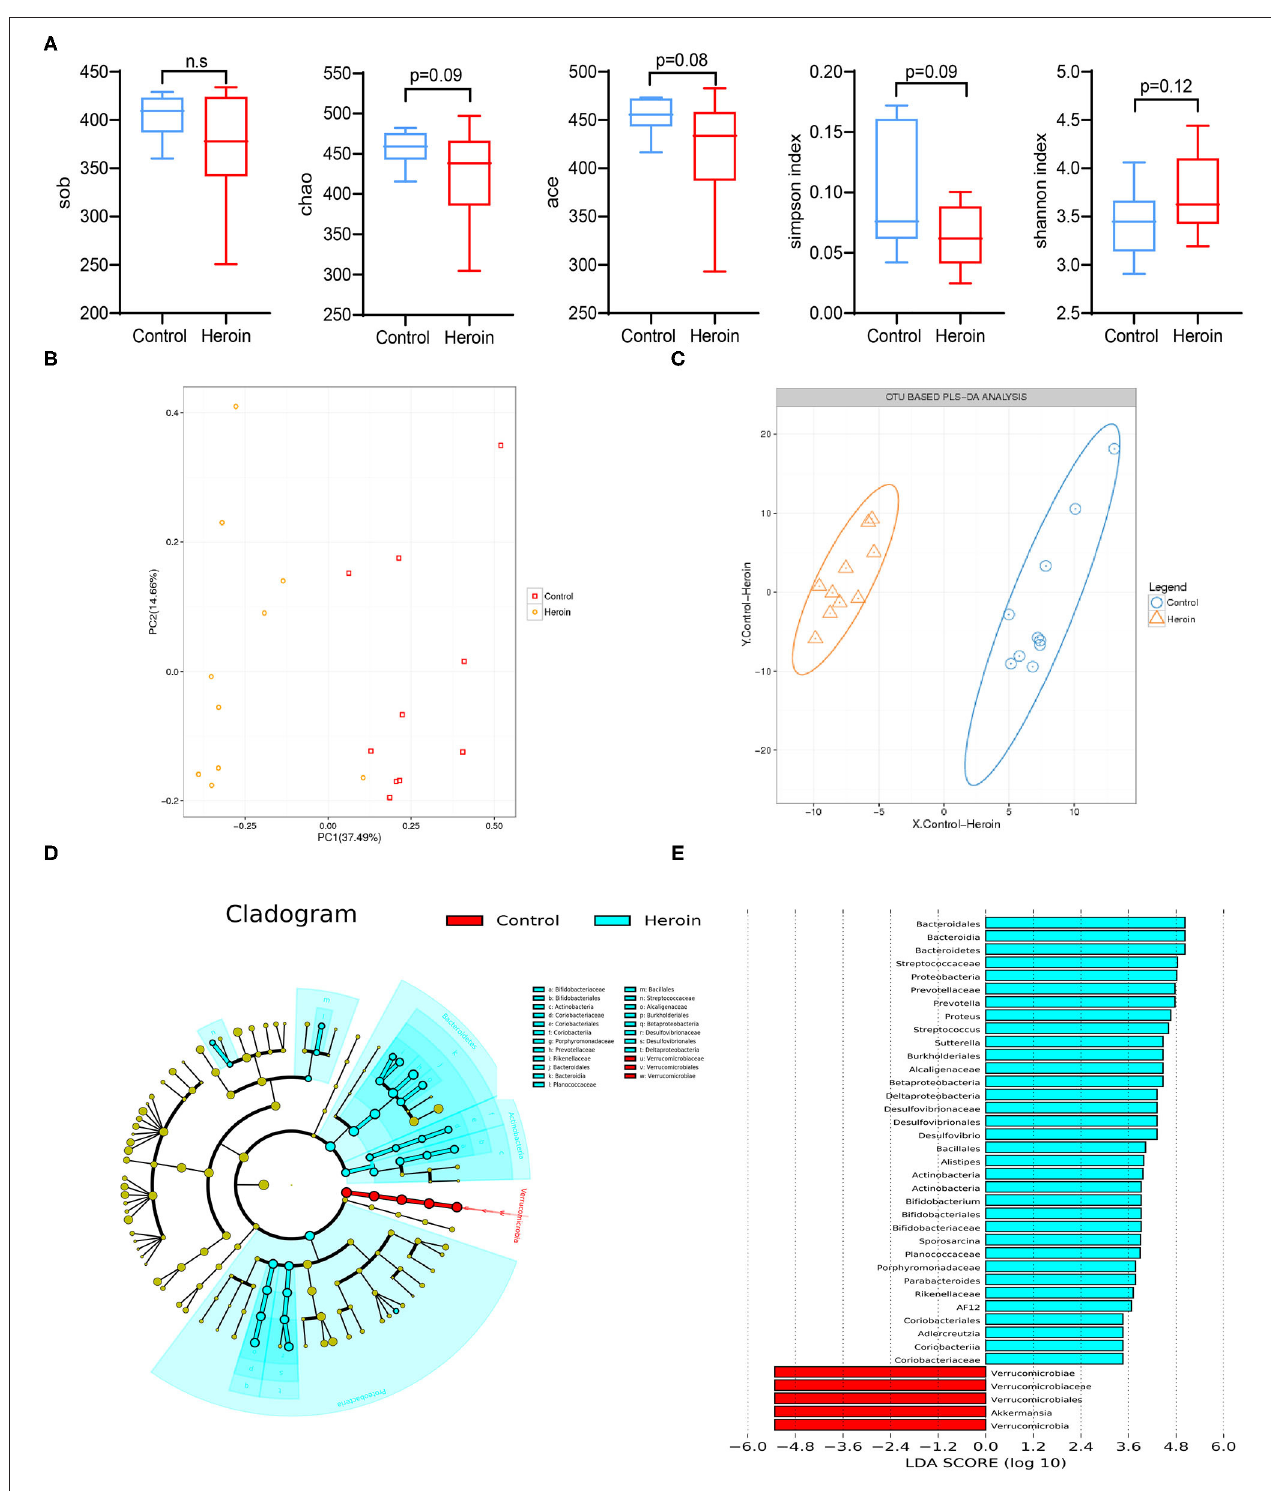
FIGURE 3 | Heroin administrated altered the gut microbiota structure and diversity. (A) Comparison of the alpha-diversity indices between the control and heroin groups based on the observed species, chao, ace, shannon, and simpson index. (B) Principal coordinate analysis (PCoA) of the samples using Unweighted-UniFrac from pyrosequencing. The red squares represent the control group, and the yellow dots represent the heroin administrated group. The fecal microbiotas of the two groups could be divided into clusters according to community composition using Unweighted UniFrac metrics and separated clearly using PCoA analysis. (C) Operational taxonomic unit (OUT)-based partial least-squares discrimination analysis (PLS-DA). (D) Linear discriminant analysis effect size (LEfSe) cladogram representing differentially abundant taxa. (E) Linear discriminant analysis (LDA) scores, as calculated by the LEfSe of differentially abundant taxa in the two groups. Cladogram showing differentially abundant taxonomic clades with an LDA score > 2.0 among cases and controls.